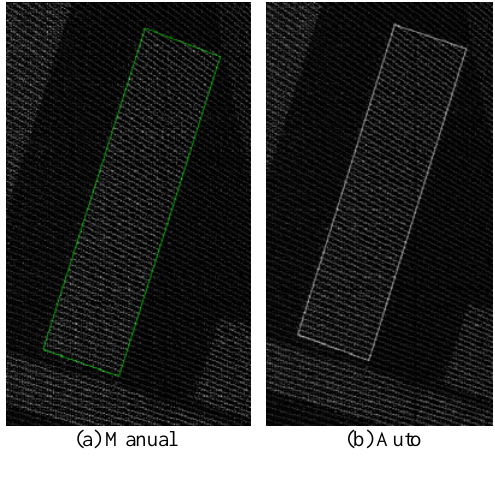
Figure 25. Compare to extract result Manual